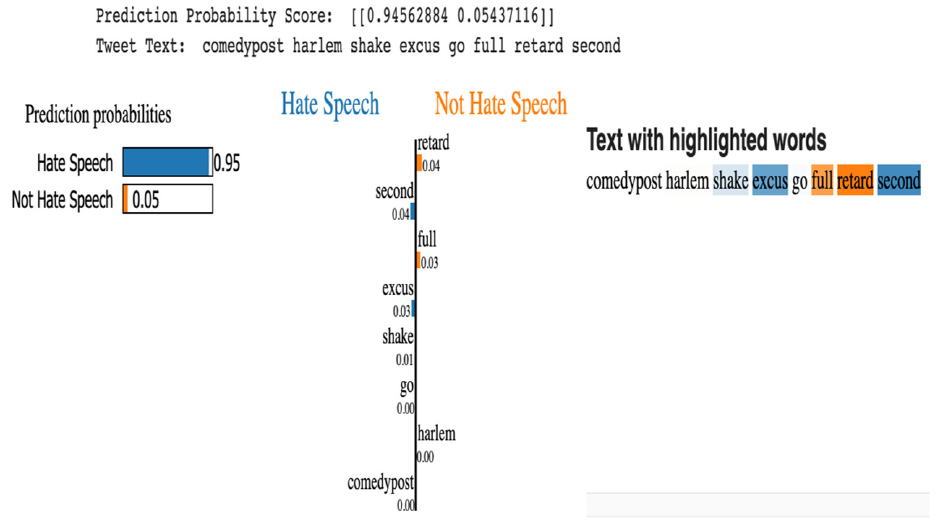
Figure 10. Explainability with logistic